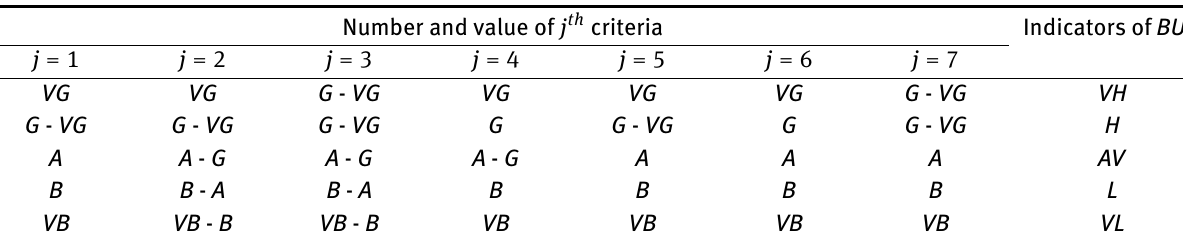
Table 1: Criteria values adopted by the expert for indicators of building utility value Number and value of j th